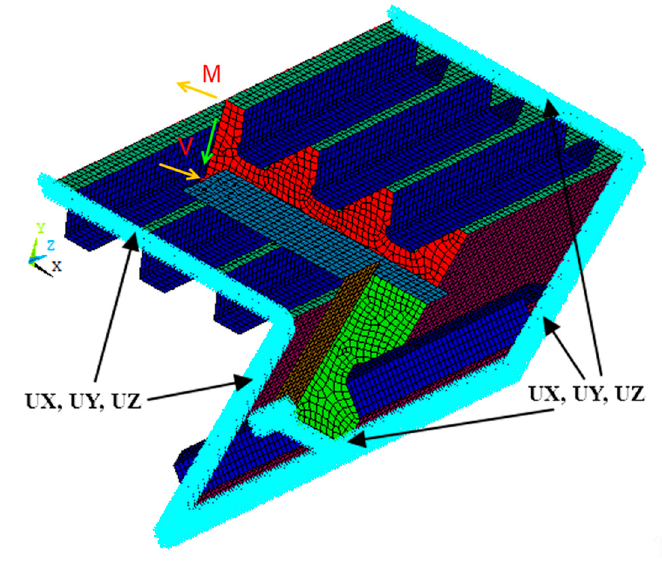
Figure 6. Finite element model (mesh, boundary, and loading conditions).